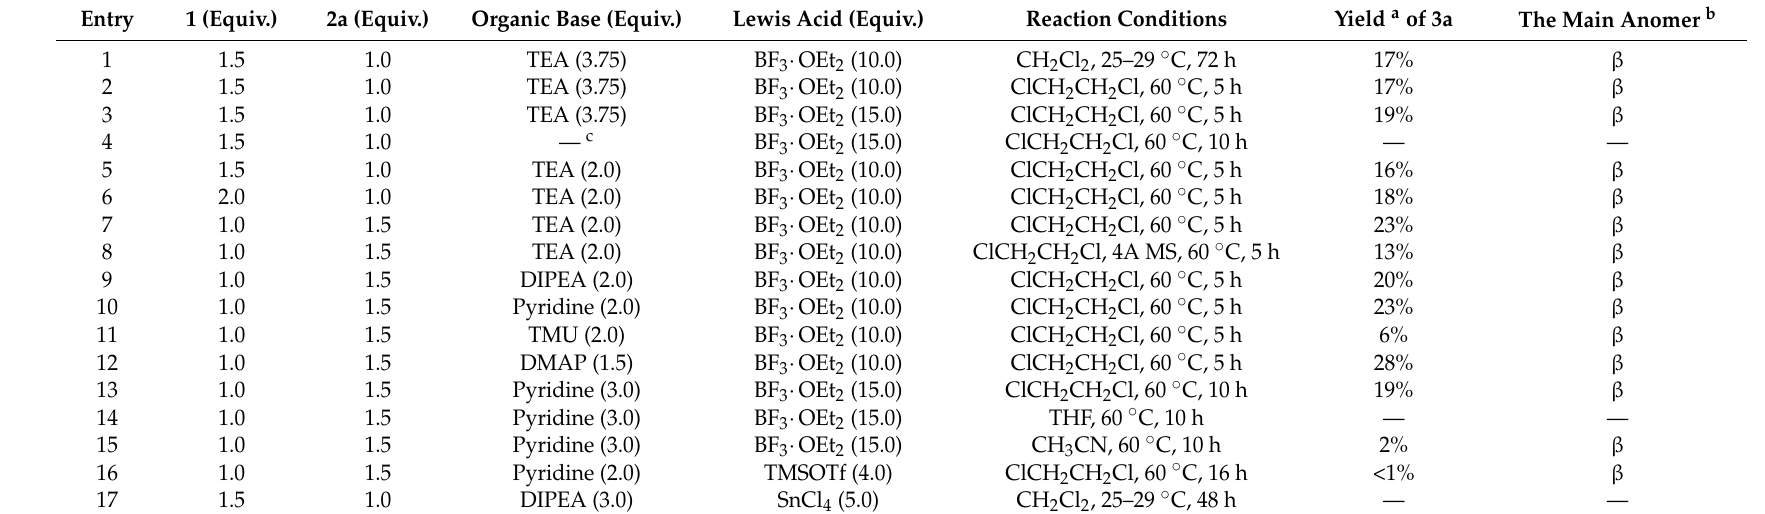
Table 1. Glycosylation of 4-MU ( 1 ) with methyl tetra- O -acetyl- β - D -glucopyranuronate ( 2a